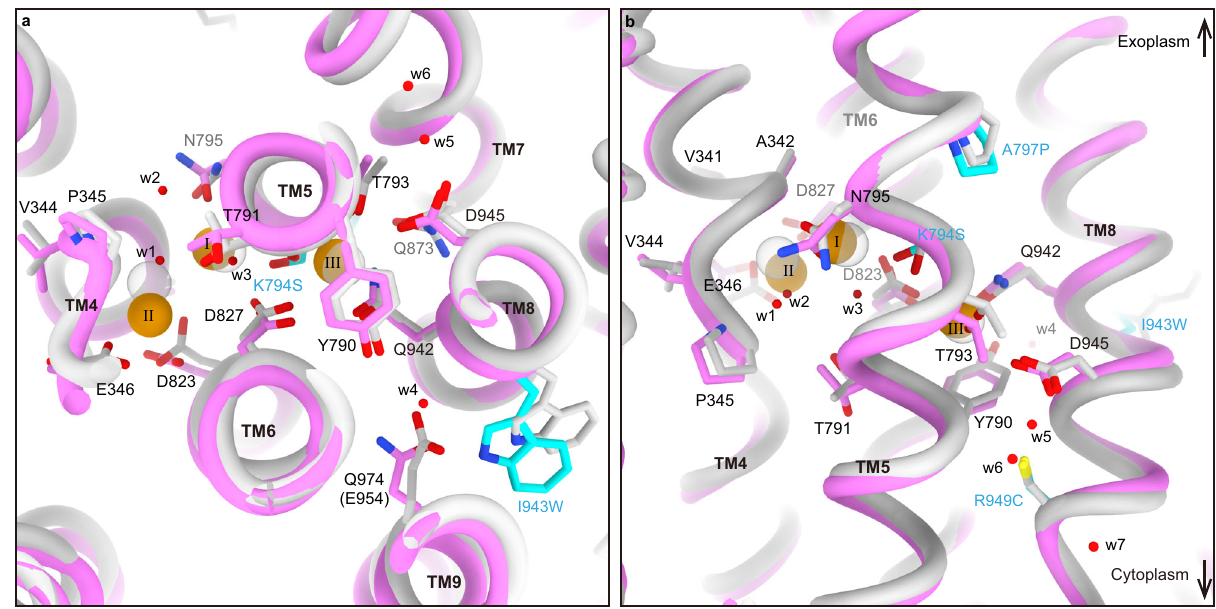
Fig.7|Comparisonofthecation-bindingsitebetweenSPWC-ngHKAandNKA. a , b Overlappedcation-bindingsitesofSPWC-ngHKAinthe3Na + ·E1-ATPstate(pink tubes and sticks) and the (3Na + )E1P-ADP state of NKA (light gray, 3wgu) viewed from cytoplasmic side ( a ), or parallel to the membrane with the extracellular side-